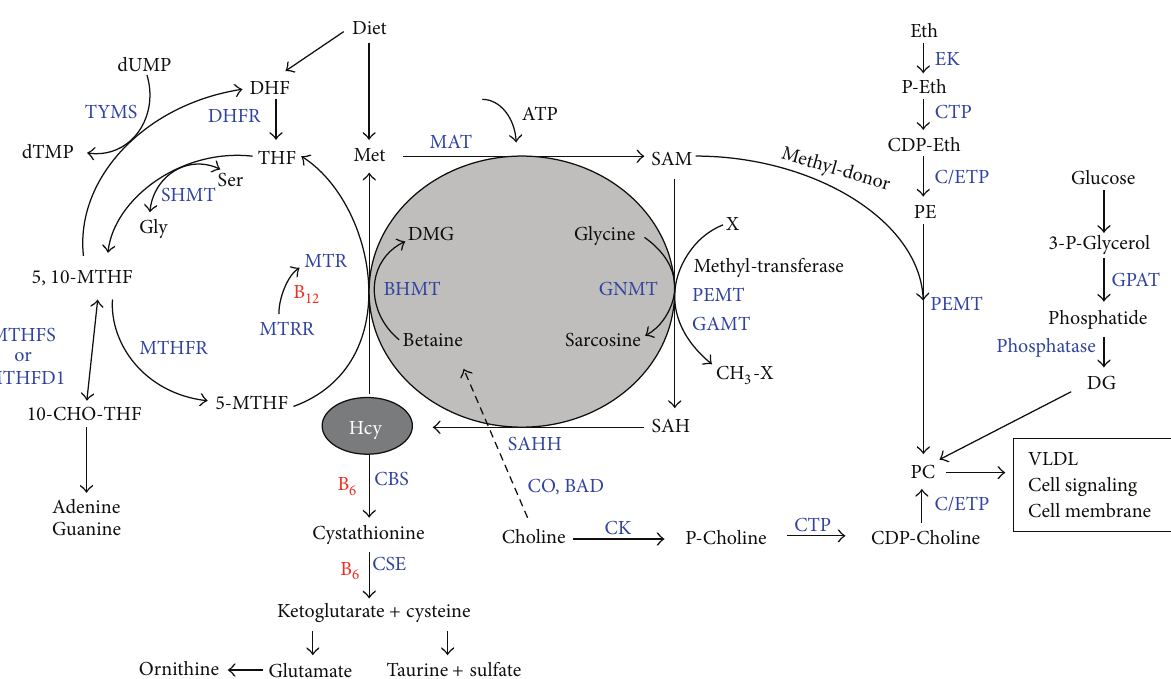
Figure 2: Homocysteine metabolism. Mthfr :methylenetetrahydrofolate reductase; Sahh :S-adenosylhomocysteine hydrolase; Bhmt :betaine- homocysteine methyltransferase; Cbs : cystathionine beta synthase; Mat1a : methionine adenosyltransferase I, alpha; Pemt : phosphatidyletha- nolamine N-methyltransferase; Cse : cystathionine gamma-lyase; Chka : choline kinase alpha; Tyms : thymidylate synthetase; Chdh : choline dehydrogenase; Gnmt : glycine N-methyltransferase; Mthfs : 5,10-methenyltetrahydrofolate synthetase; Mtr : 5-methyltetrahydrofolate- homocysteine methyltransferase; Cept1, choline/ethanolamine phosphotransferase 1; Mtrr : 5-methyltetrahydrofolate-homocysteine methyl- transferase reductase; Bad : betaine aldehyde dehydrogenase; Etnk1 : ethanolamine kinase 1.